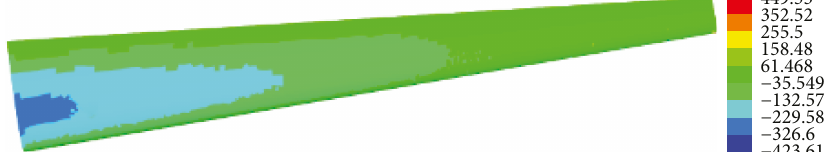
Figure 30: Stress cloud diagram of the upper wing with the layer angle being 45 and